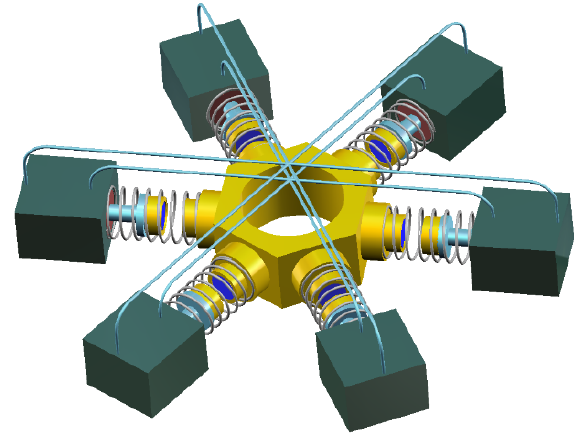
Figure 1. Three-dimensional (3D) model of the vibration energy absorbing mechanism (VEAM).